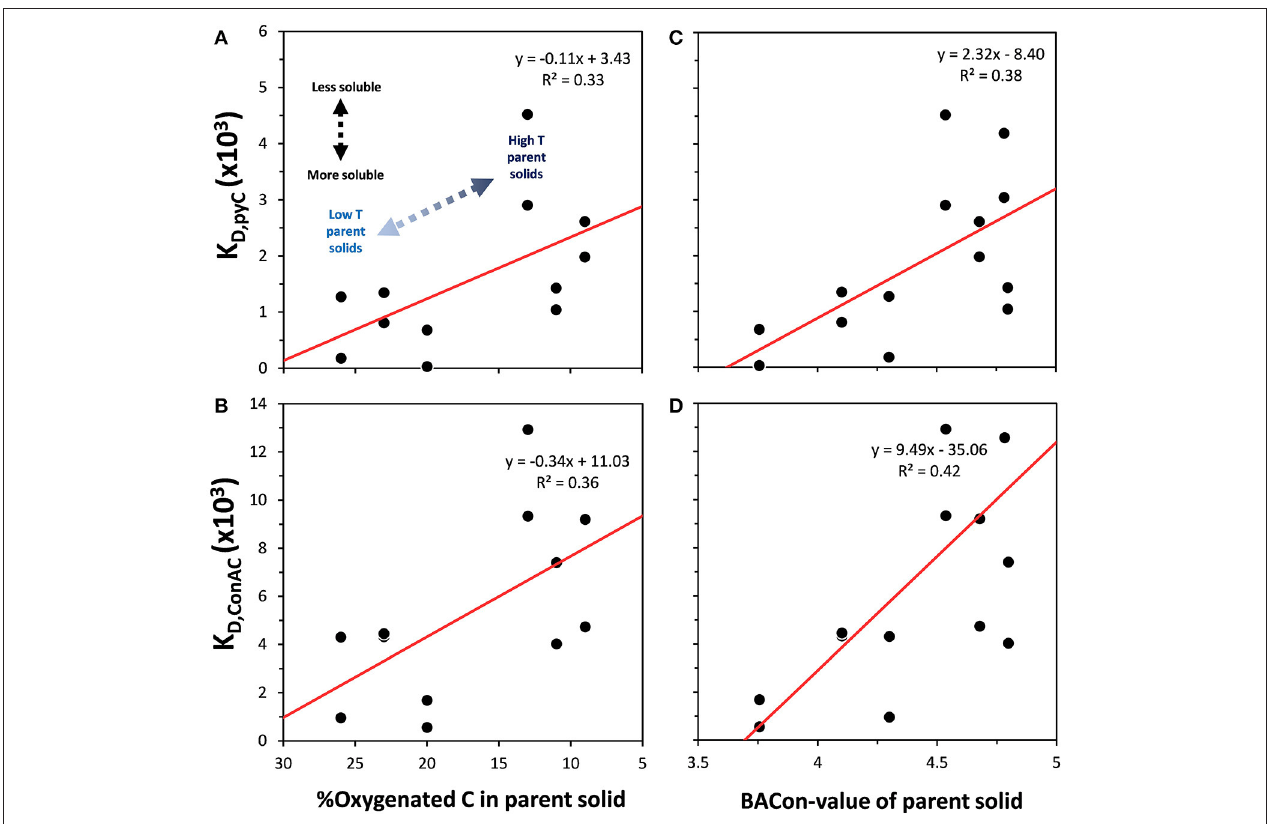
FIGURE 7 | Relationship between the solid-liquid distribution coefficients of bulk pyC and ConAC compounds yielding B5CA-C and B6CA-C (i.e., K D, pyC and K D, ConAC , respectively) in “Early” and “Late” leachates and %C in parent solid O-containing functional groups ( A,B , respectively), and aromatic cluster size as indicated by the BACon Index ( C,D , respectively). All linear correlations are statistically significant ( p < 0.05).